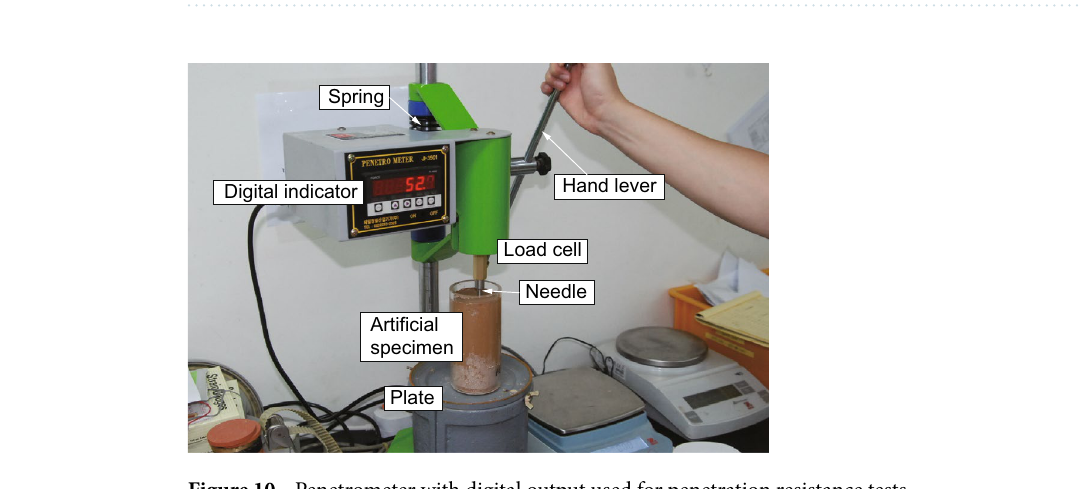
Figure 10. Penetrometer with digital output used for penetration resistance